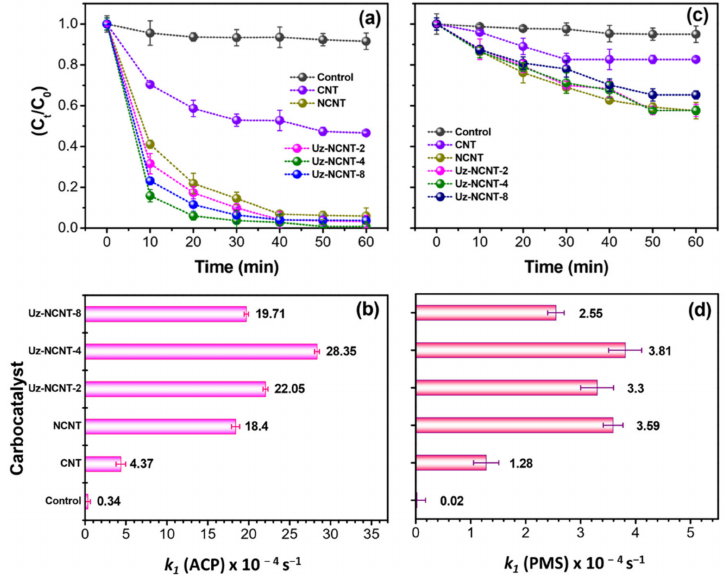
Figure 1. ( a ) ACP degradation profile versus time and ( b ) first-order kinetic rate constant, k 1 (ACP). ( c ) PMS decomposition profile versus time and ( d ) k 1 (PMS). Experimental conditions C ACP = 10 mg L − 1